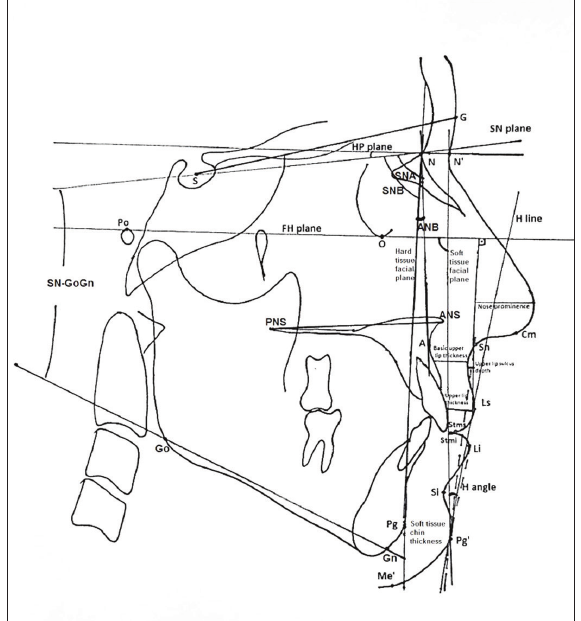
Figure 1. Cephalometric landmarks and reference planes: (1) S, midpoint of sella turcica; (2) N, anterior point at nasofrontal suture; (3) Po, most superior point of external auditory meatus; (4) O, most inferior point of the orbit; (5) A, deepest point in concavity of anterior maxilla; (6) ANS, most anterior point of anterior nasal spine; (7) PNS, most posterior point of nasal spine; (8) Go, point constructed by bisecting the posterior and inferior borders of the mandible; (9) Me, most inferior point of bony chin; (10) Pg, most anterior point of bony chin; (11) Gn, most anterior-inferior point of bony chin; (12) G, the most prominent point in the midsagittal plane of supraorbital ridge; (13) N’, soft tissue nasion, the most concave point in the tissue overlying the area of the frontonasal suture; (14) Cm, columella, the most anterior soft tissue point on the columella (nasal septum) of the nose; (15) Sn, subnasale, the point at which the columella merges with the upper lip in the midsagittal plane; (16) Ls, labrale superius, most anterior point on the upper lip; (17) Stms, stomion superius, lower most point on vermillion of upper lip; (18) Li, labrale inferius, most anterior point on the lower lip; (19) Stmi, stomion inferius, upper most point on vermillion of lower lip; (20) Si, sulcus inferius, the point of greatest concavity in the midline of the lower lip between the labiale inferius and the soft tissue pogonion; (21) Pg’, soft tissue pogonion, the most anterior point on the soft tissue chin; (22) Me’, soft tissue menton, the most inferior point on the soft tissue chin; (23) HP, horizontal reference line constructed by raising a line 7 degree from S-N plane; (24) FH, reference line through Po and O; (25) Hard tissue facial plane, line from N to Pg; (26) Soft tissue facial plane, line from N’to Pg’; (27) H line, line drawn tangent to the soft tissue chin and upper